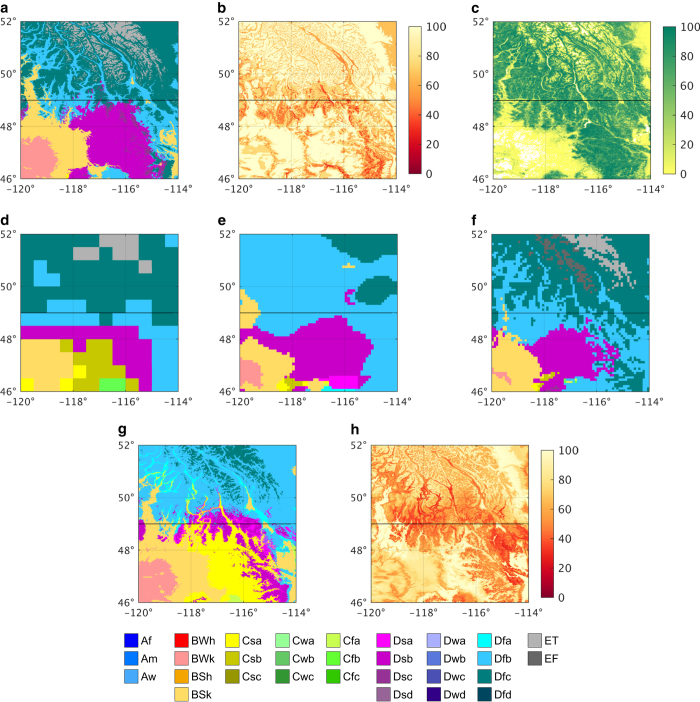
Köppen-Geiger classifications, and associated maps, for the central Rocky Mountains (North America).Part (a) present-day results from our study (1980–2016); (b) confidence levels associated with our present-day map; and (c) forest cover map36 (2000). Historic Köppen-Geiger classification maps for the three previous studies are provided as: (d) Kottek et al.20 (1951–2000); (e) Peel et al.21 (1916–1992); and (f) Kriticos et al.22 (1960–1990). Our future Köppen-Geiger map (2071–2100) is presented in (g) and the corresponding confidence map in (h). The representative period of each map is listed in parentheses. The thick black line at 49° latitude represents the Canada-US border.